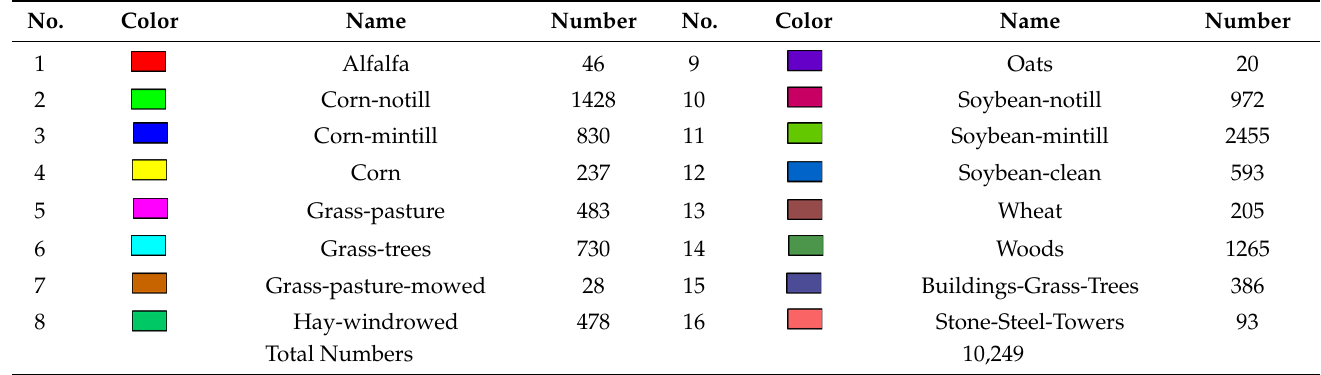
Table 2. Land cover types and total number of samples in the PaviaU dataset.